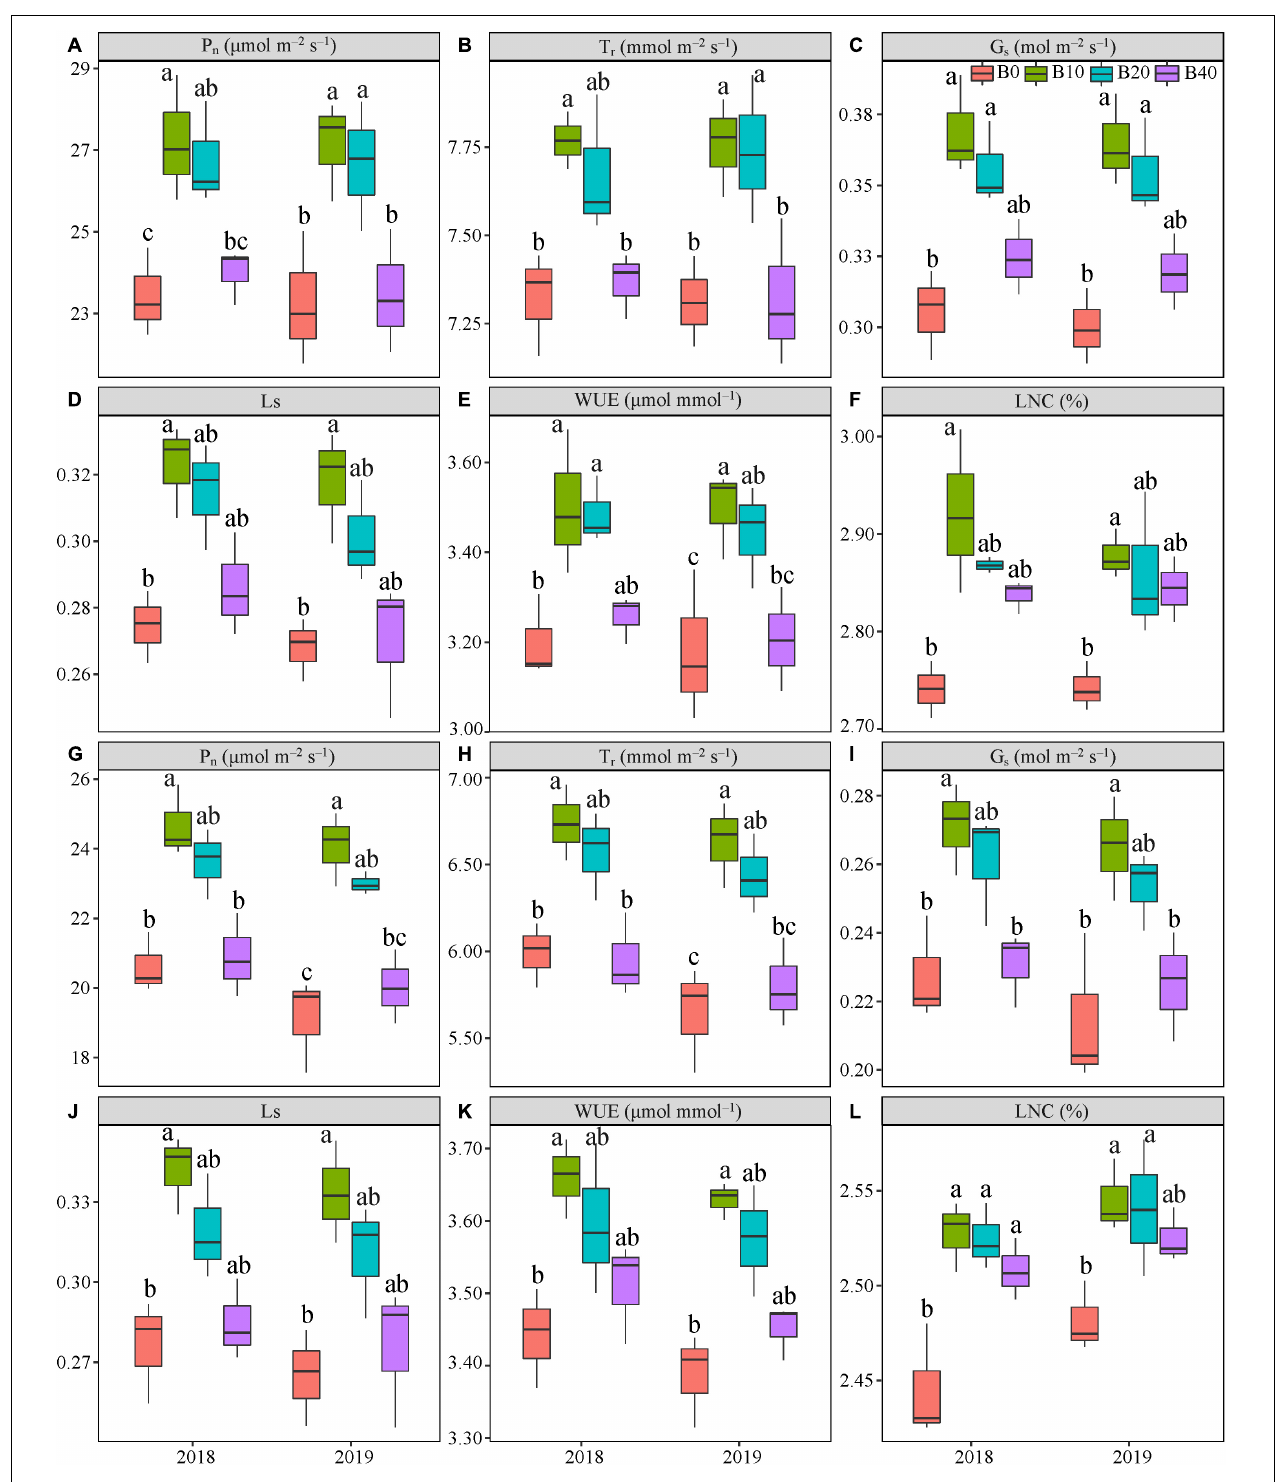
FIGURE 3 | Gas exchange parameters at flowering (A–F) and pod set (G–L) in peanut applied with four biochar rates in 2018 and 2019 growing seasons. Y and B represent year and biochar application, respectively. P n , net photosynthetic rate; T r , transpiration rate; G s , stomatal conductance; L s , stomatal limitation; WUE, water-use efficiency; and LNC, leaf nitrogen content. B0, B10, B20, and B40 represent biochar application rates of 0, 10, 20, and 40 t ha − 1 , respectively. For each parameter in each year, mean data with different letters denote significant differences among treatments at P < 0.05.